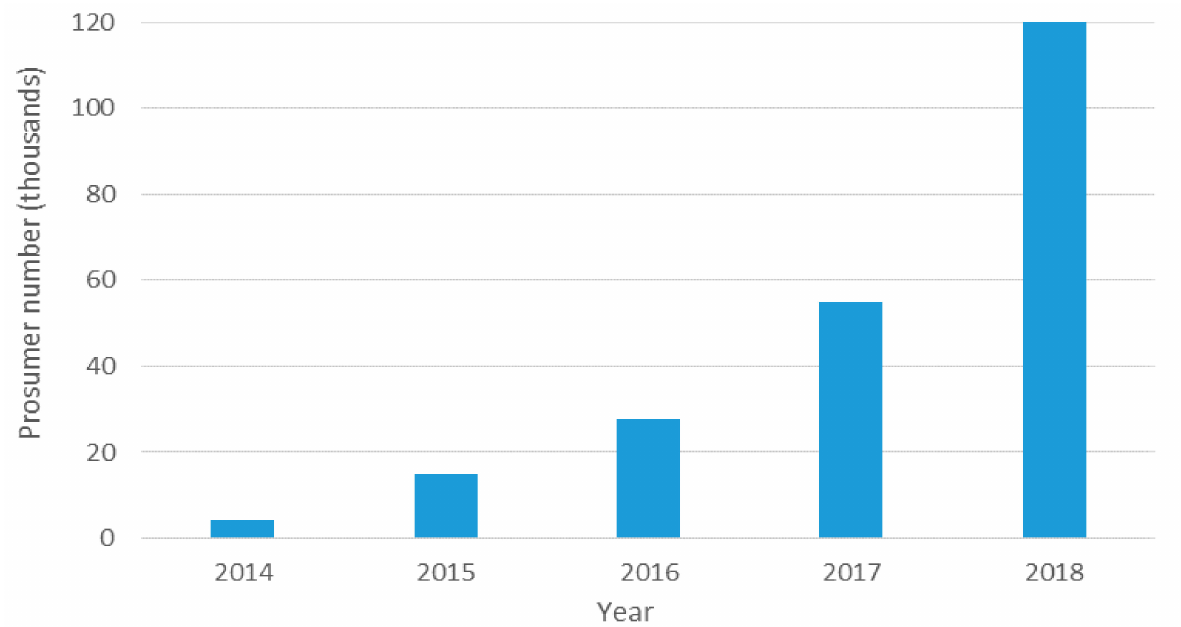
Figure 7. Number of prosumer PV installations in Poland 2012–2019. Own elaboration based on data from